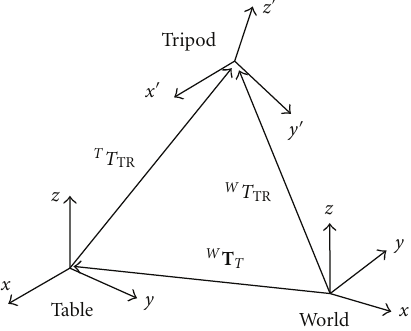
Figure 8: Calibration of tripod machine